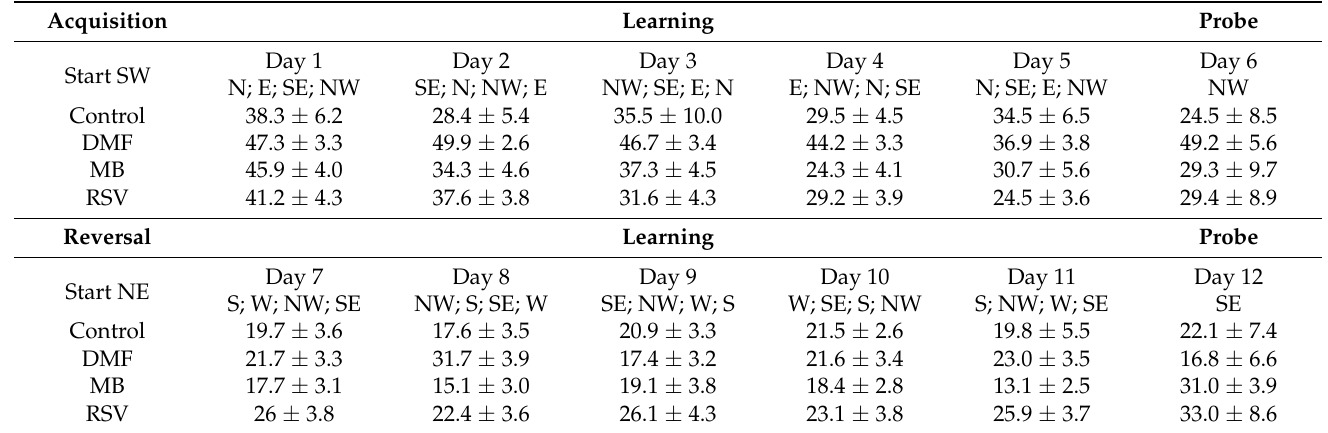
Table 3. The time that mice spent on the platform search.